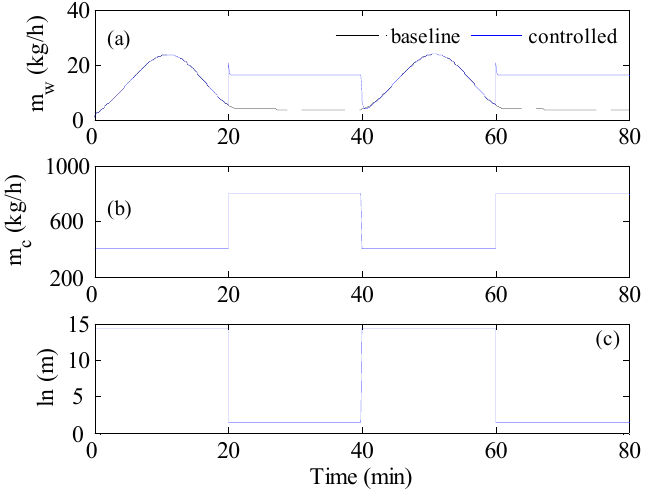
Figure 11. Optimal control results without constraints for sine-like wave inlet hot temperature, 𝑚 (cid:3035)(cid:3036)(cid:3041) = 400 (cid:2921)(cid:2917) ;𝑇 (cid:3035)(cid:3036)(cid:3041) = 80 (cid:2925) C , ( a ) Productivity, ( b ) cold stream flow rate, ( c ) module length.